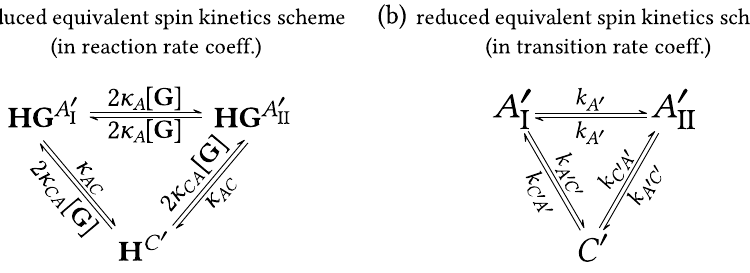
Figure 9. Reduced equivalent spin kinetics schemes for the multi-state system of di-bromobenzylated oxoporphyrinogen (host H ) in the presence of two ligands, ( R )-camphorsulfonic acid (ligand G ) and water (ligand W ). Schemes refer to the central NH protons of the host molecule. ( a ) Spin kinetics in terms of reaction rate coefficients as obtained from contraction of the scheme in Fig. 8c. ( b ) Corresponding spin kinetics in terms of transition rate coefficients. It has the form of half-symmetric three-state exchange. Comparison with ( a ) gives the relationship between transition and reaction rate coefficients in Eq. (26). This scheme represents experimentally observed spin kinetics. It was used for lineshape fitting, see SI Section S12 for